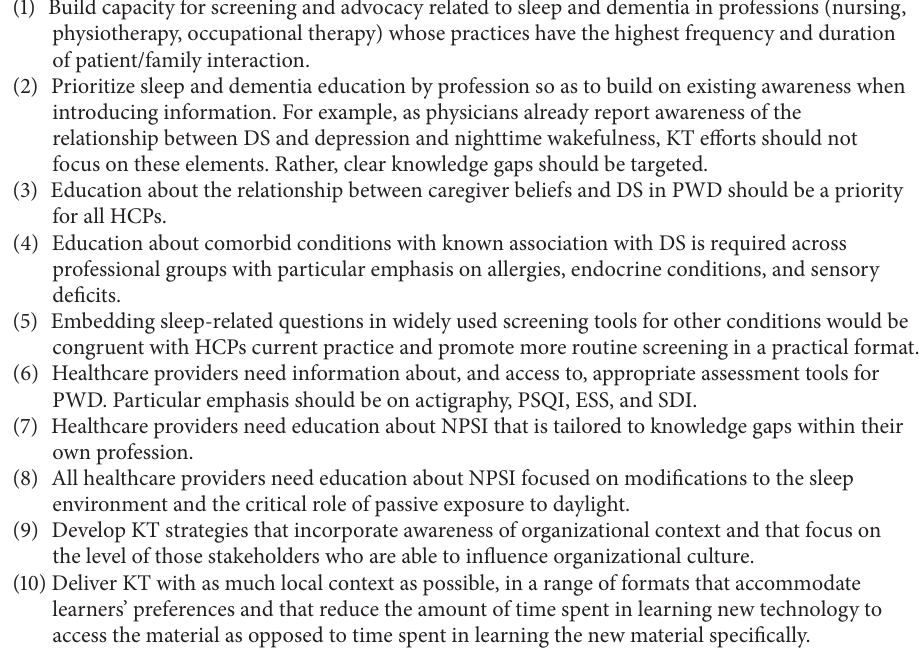
Box 1: Action points for NPSI KT